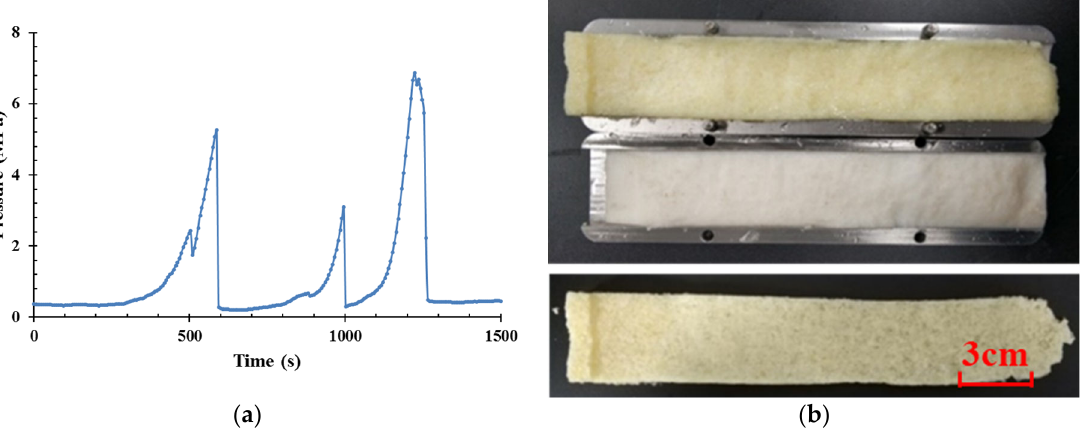
Figure 5. Pressure curve and temporary plugging zone morphology of experiment 3. ( a ) Pressure curve; ( b ) Temporary plugging zone morphology.